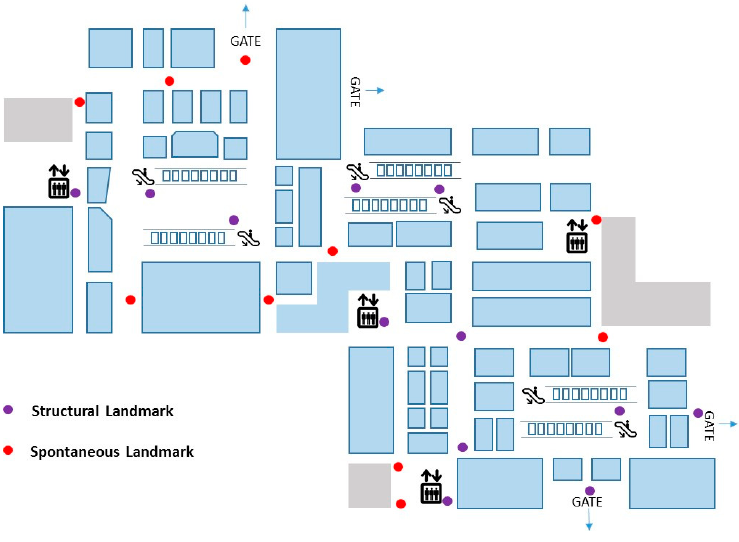
Figure 3. Example of landmarks detection.